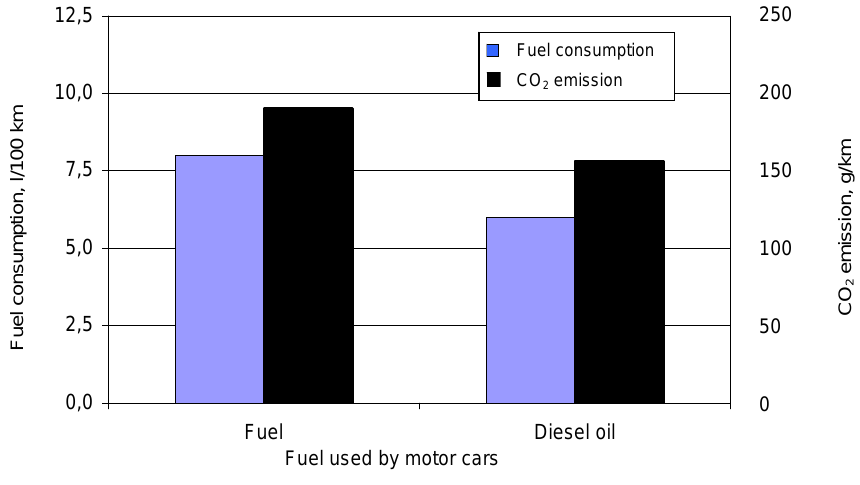
Fig 1. Average fuel consumption and CO 2 emission by motor cars depending on the fuel used